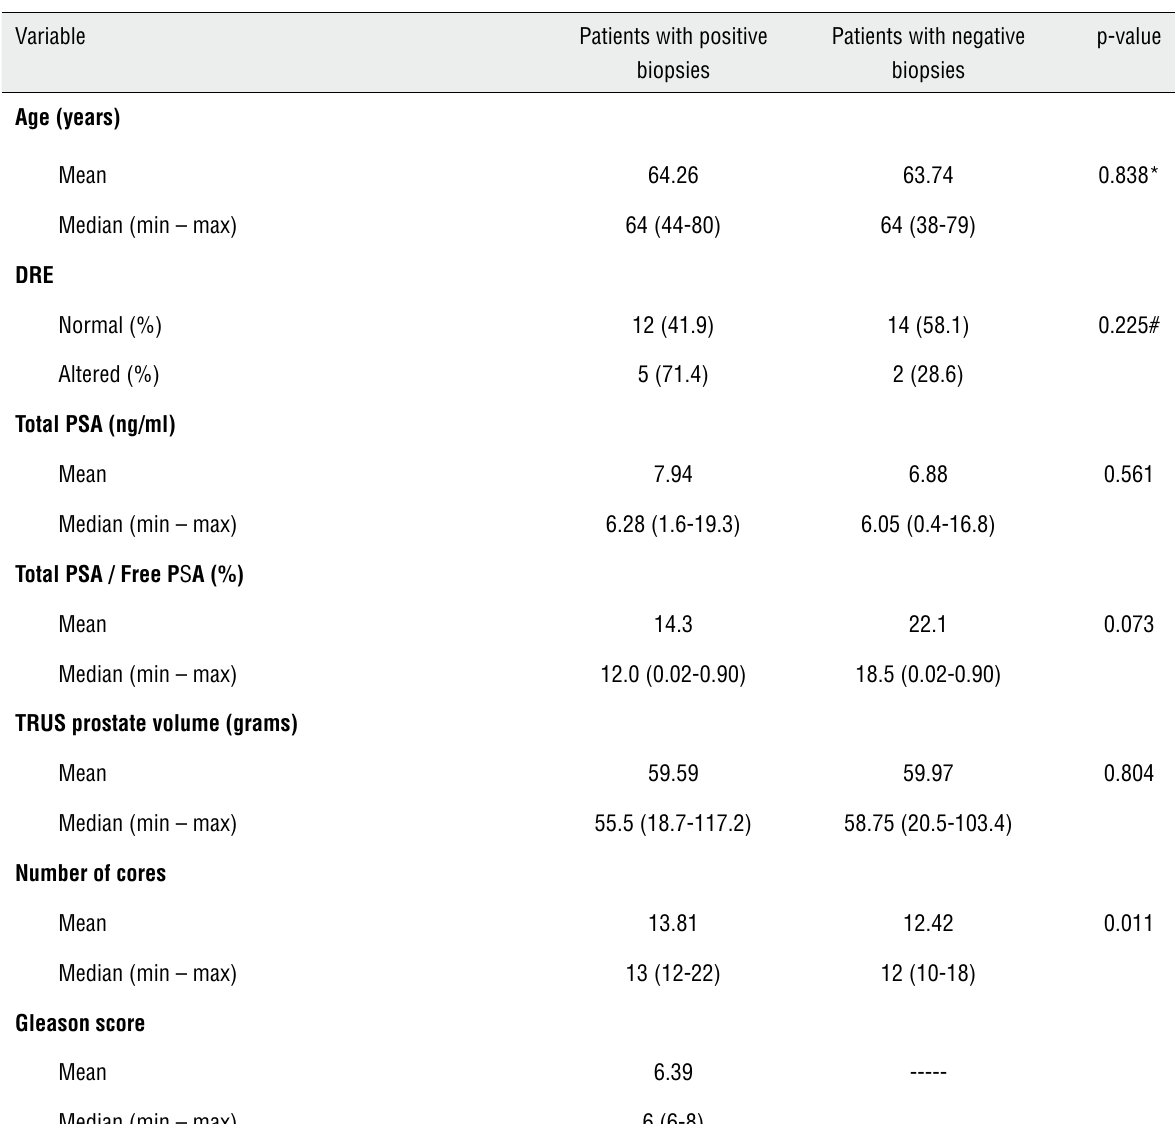
Table 1 - Demographic characteristics of patients.